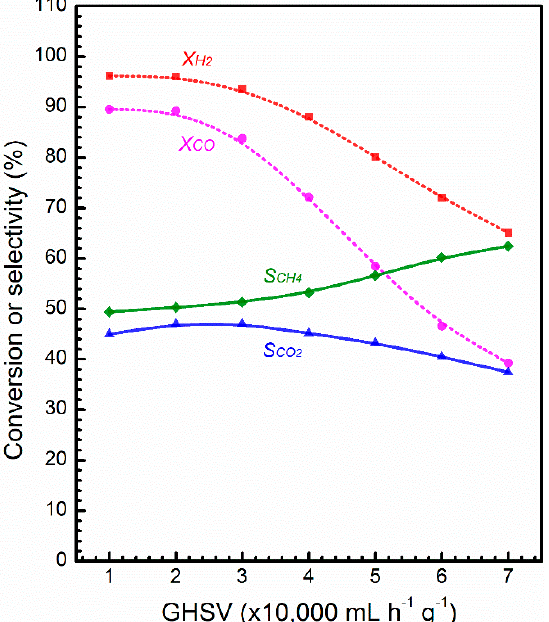
Figure 4. Conversions and selectivities over Ni/MgAl 2 O 4 -E as a function of gas hourly space velocity at 450 °C. at 450 ◦